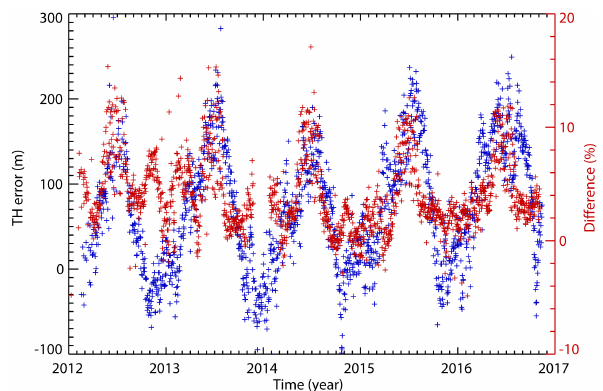
Figure 15. The time series of daily ARRM TH error (blue) and zonal mean ozone differences (%) between OMPS LP and Aura MLS (red) at 50 ◦ N for the center slit. Note the similarity in time- dependent patterns for ozone differences and TH error derived from AARM method. The fact that these two completely independent methods show very similar patterns gives us additional confidence in